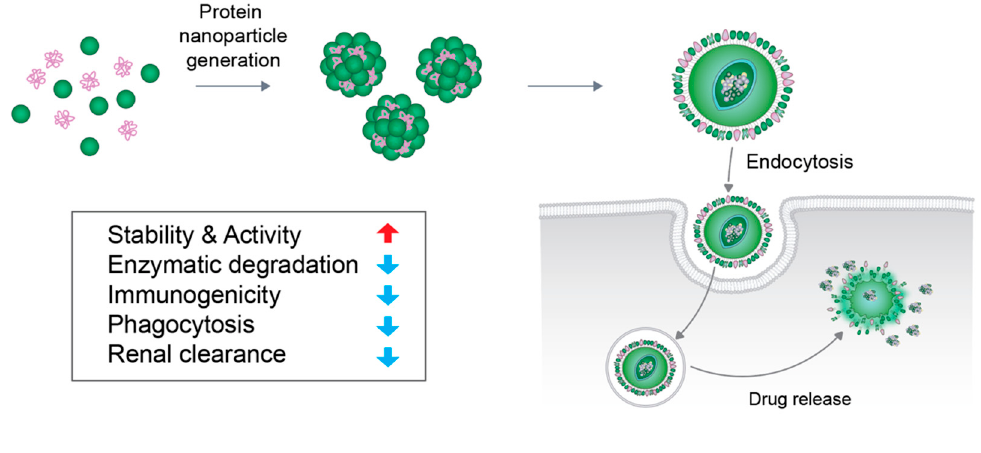
Figure 1. Delivery of protein nanoparticle to the cell. Intracellular delivery of insoluble drugs by protein nanoparticles via the endocytosis process. Protein nanoparticles have several advantages as a drug delivery system, such as increased stability and activity due to increased protection from enzymatic degradation, immunogenicity, phagocytosis, and renal clearance, thereby leading an increase in the half-life of the drug.